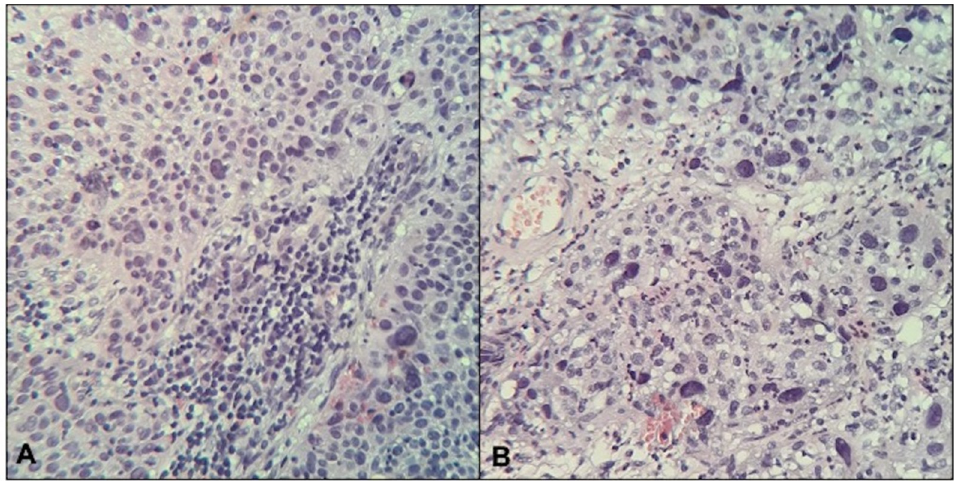
Figure 1. Histological sections (H&E, magnification 20×) of two cases of cervical cancer with high ( A ) and low ( B ) tumor-infiltrating lymphocytes (TILs). high ( A ) and low ( B ) tumor-infiltrating lymphocytes